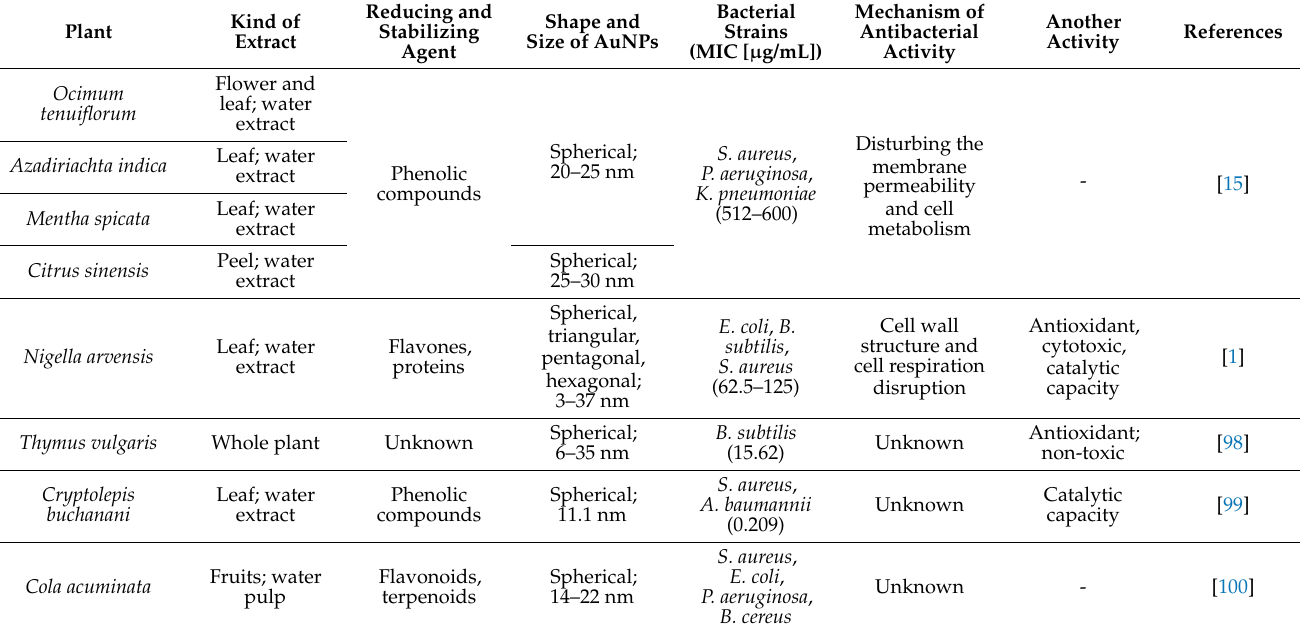
Table 2. Antibacterial activity and mechanism of antibacterial action of AuNPs synthesized from plant